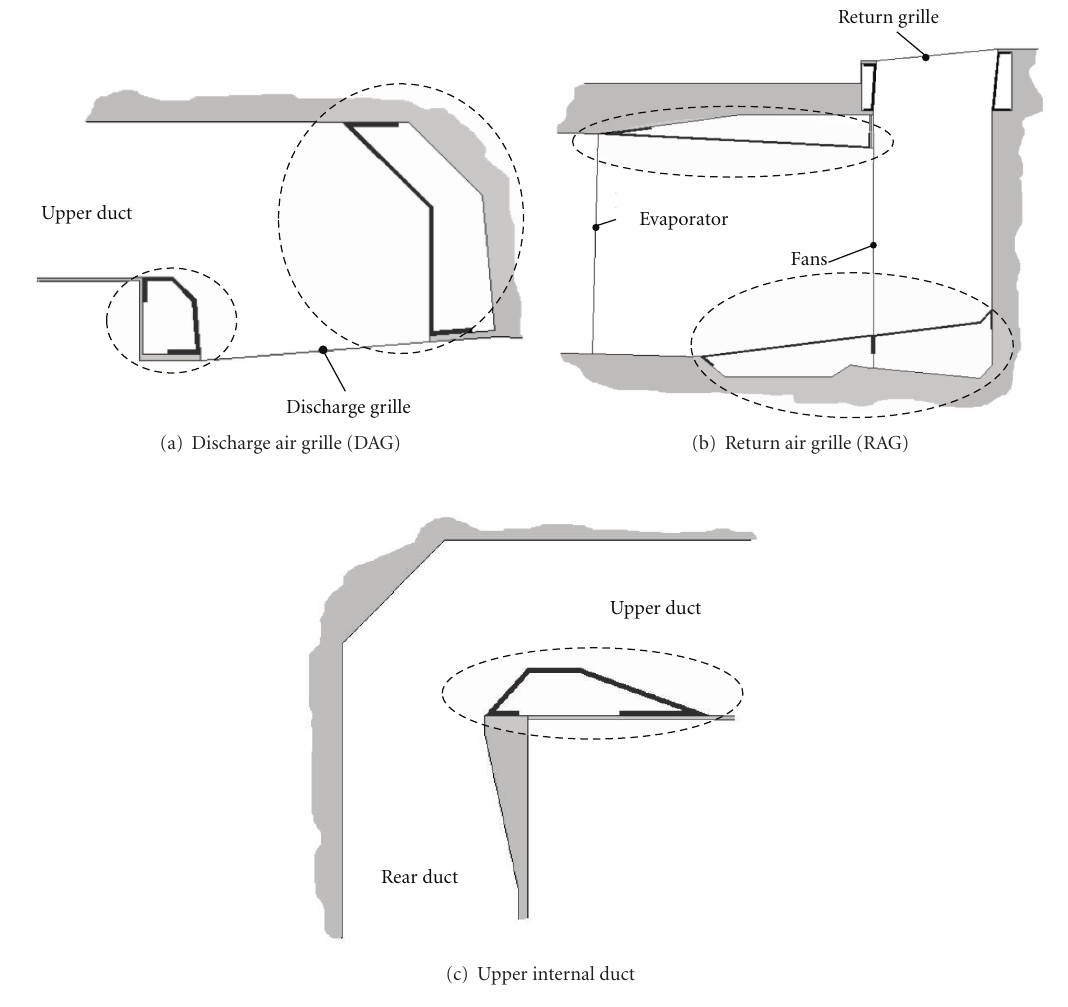
Figure 8: Internal duct modifications.